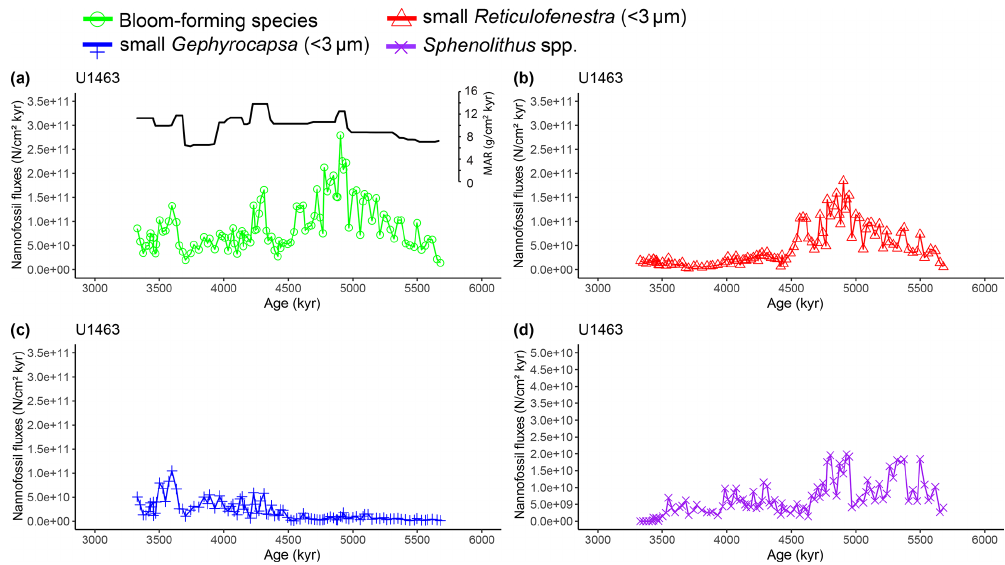
Figure A5. Latest Miocene to early Pliocene nannofossil fluxes (NAR; Ncm − 2 kyr − 1 ) of the dominant calcareous nannofossil species at IODP Site U1463. (a) Bloom-forming species ( < 5µm Reticulofenestra and < 3µm Gephyrocapsa ; green circles) with inset bulk sediment MAR (gcm − 2 kyr − 1 ; black line), (b) small ( < 3µm) Reticulofenestra (red triangles), (c) small ( < 3µm) Gephyrocapsa (blue plus signs), and (d) Sphenolithus spp. (purple crosses). Error bars of maximum replication error (15%; Bordiga et al., 2015) were too small and therefore impaired the visual inspection of the figure. However, they are available as part of the source data of the paper. Note the different y axis scale in panel (d) .